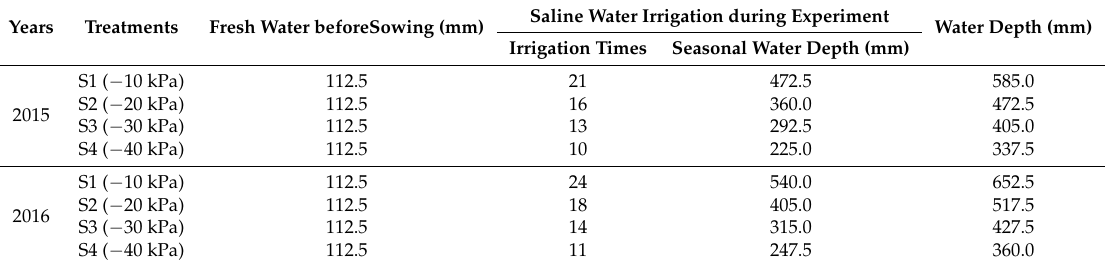
Table 6. Irrigation and amount of applied water for each treatment during the experiment period in 2015 and 2016.